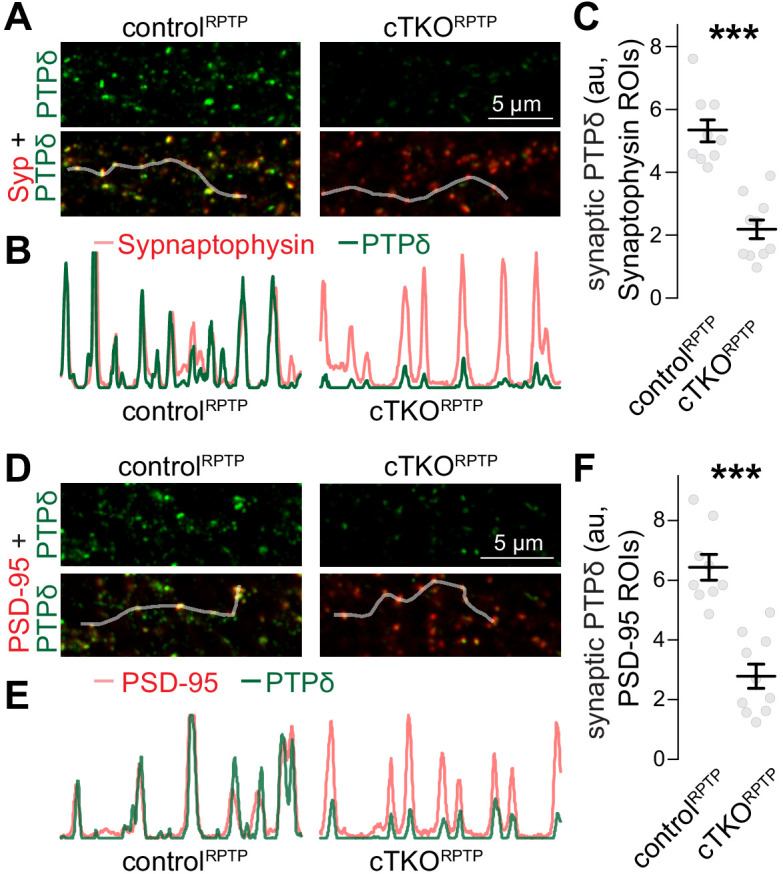
Confocal analyses of PTPδ.(A–C) Sample confocal images (A), sample intensity profiles (B), and quantification (C) of PTPδ at synapses identified by Synaptophysin (Syp) staining. Intensity profiles of PTPδ and Synaptophysin (C) along the shaded lines highlighted in (A) show good correlation between the signals. In (C), PTPδ fluorescence intensities were quantified in Synaptophysin regions of interest (ROIs). The confocal images analyzed here were acquired in the same imaging session and for the same image frames as the STED analyses shown in Figure 1. Confocal images were always acquired prior to STED acquisition, N (controlRPTP) = 9 images/3 independent cultures; N (cTKORPTP) = 10/3. (D–F) Same as (A–C), but for PSD-95 ROIs. To avoid potential confounds of mildly increased Synaptophysin areas (Figure 1M), we repeated the confocal analyses generating PSD-95 instead of Synaptophysin ROIs. In diffraction-limited microscopy, the resolution is insufficient to distinguish pre- and postsynaptic markers, and either marker can be used to generate synapse ROIs. N as in (C). Data are plotted as mean ± SEM and analyzed using Mann–Whitney rank sum tests, ***p<0.001.